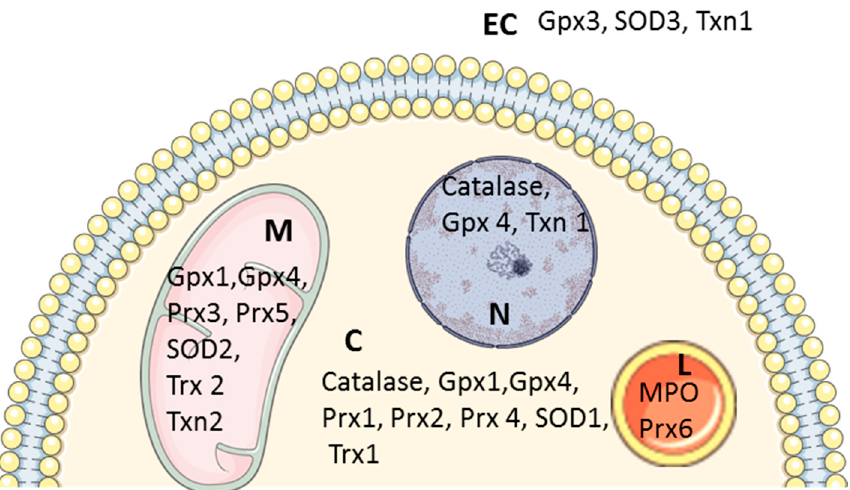
Figure 2. Compartmentalization of cardiac antioxidant enzymes. C : cytosol; EC : Extracellular Figure2. Compartmentalizationofcardiacantioxidantenzymes. C :cytosol; EC